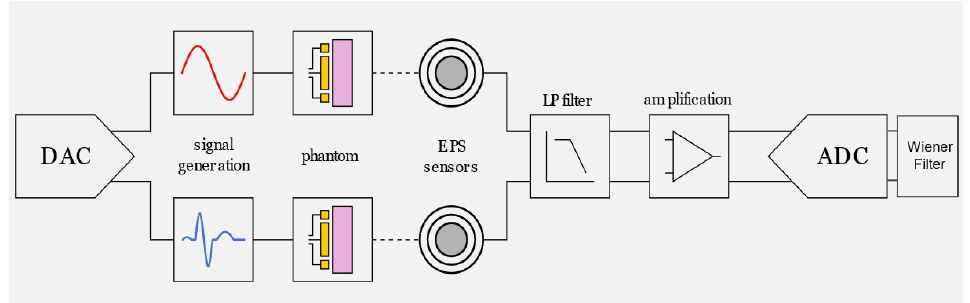
Figure 6. Block diagram of test system used to assess the proposed denoising approach using MIT-BIH database and tissue phantom.